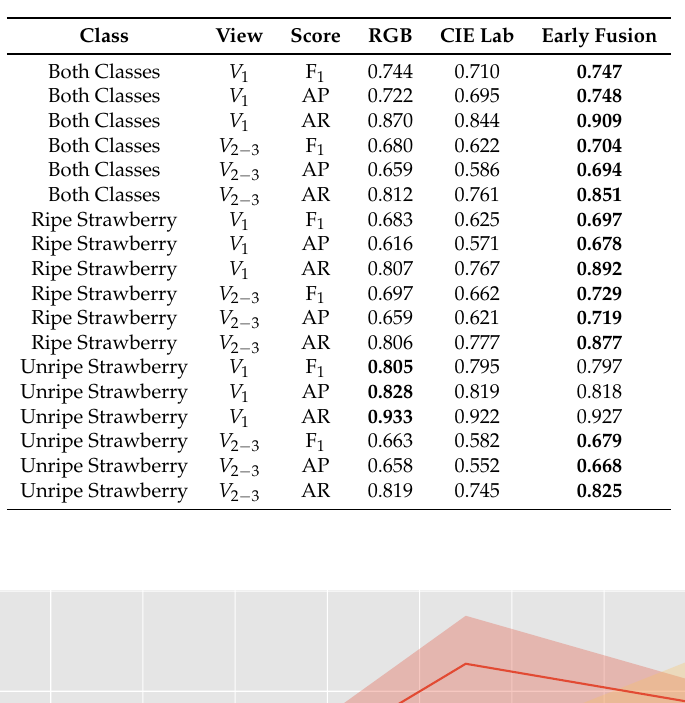
Table 4. F 1 , Average Precision (AP) and Average Recall (AR) scores of RGB , CIELab and Early Fusion at 50% intersection over union (IoU) for each detected class. Bold indicates the best result in each row.